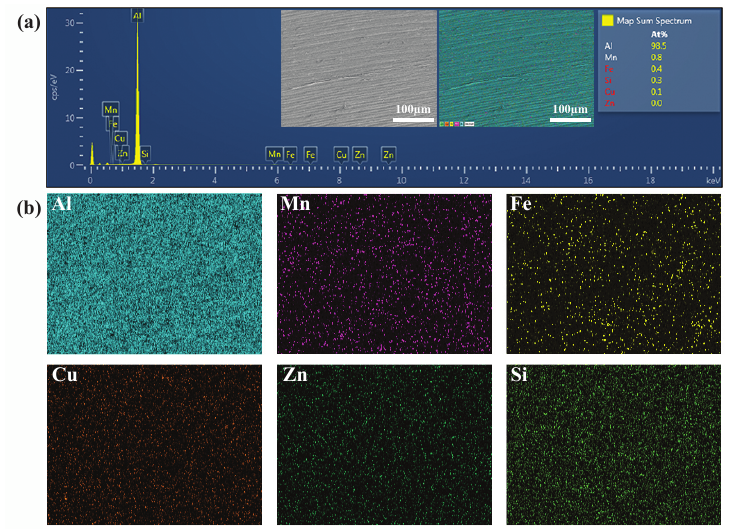
Figure 3. EDS analysis ( a ) element spectrum corresponding to AA3003. Inset images show the SEM- back scattered electron (BSE) scan area that was used for chemical composition analysis; ( b ) EDS element mapping